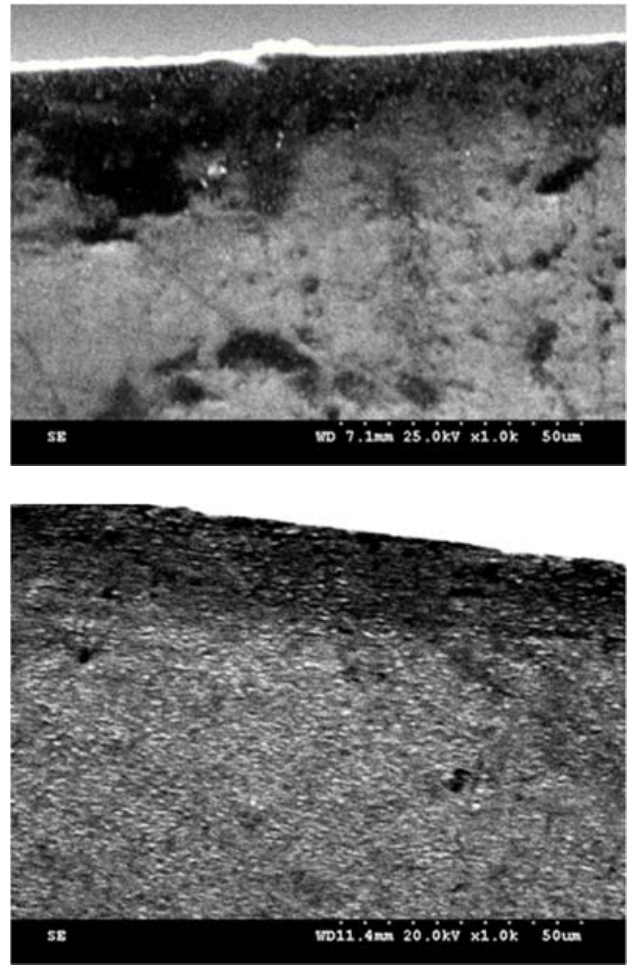
Figure 12. Comparison of imported and domestic bearing grinding deterioration layer.